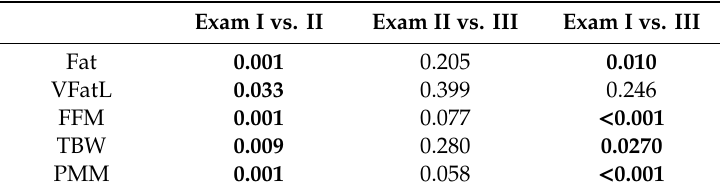
FAT: body fat; VFAT: visceral fat; FFM: fat-free mass; TBW: total body water; PMM muscle mass; bold value: statistical significance.